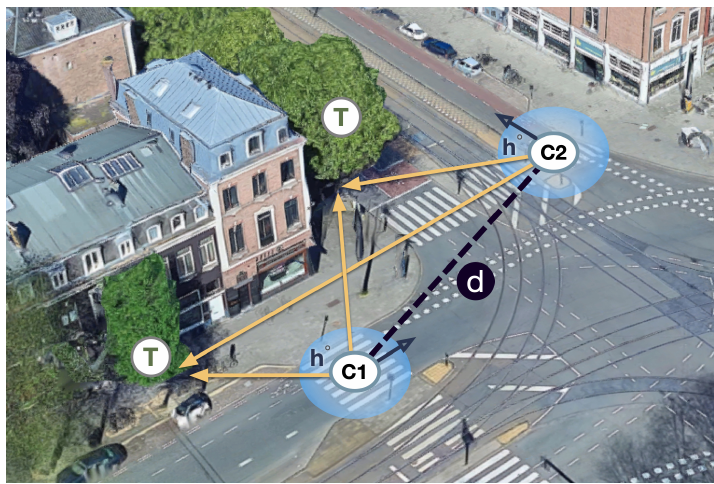
Figure 1. C*, camera with geo-position; T, the tree has its actual geographic coordinates and location within the panorama; h ◦ , heading angle inside panorama; d, distance between cameras.